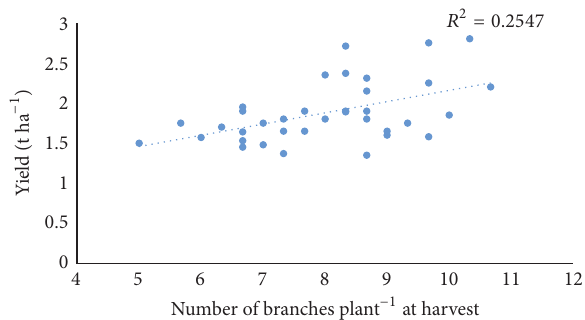
Figure 5: Relationship between number of branches/plant during harvest and yield of peanut (mean of two